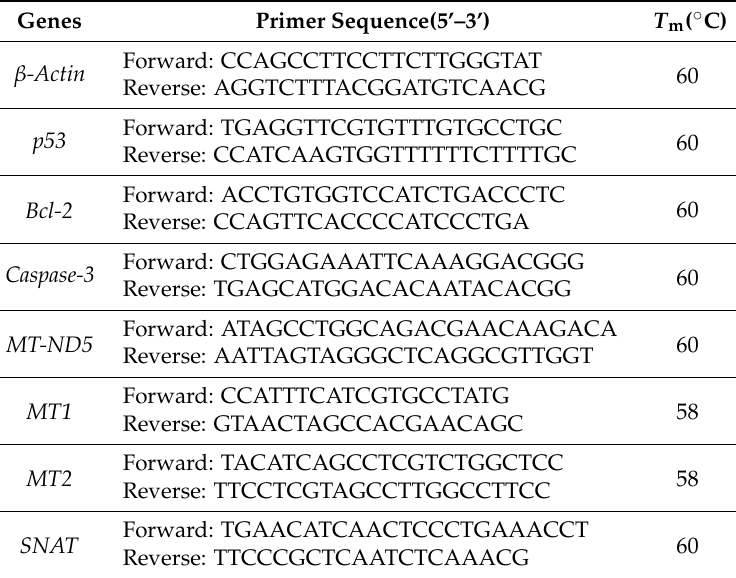
Table 1. Primers for RT-PCR and